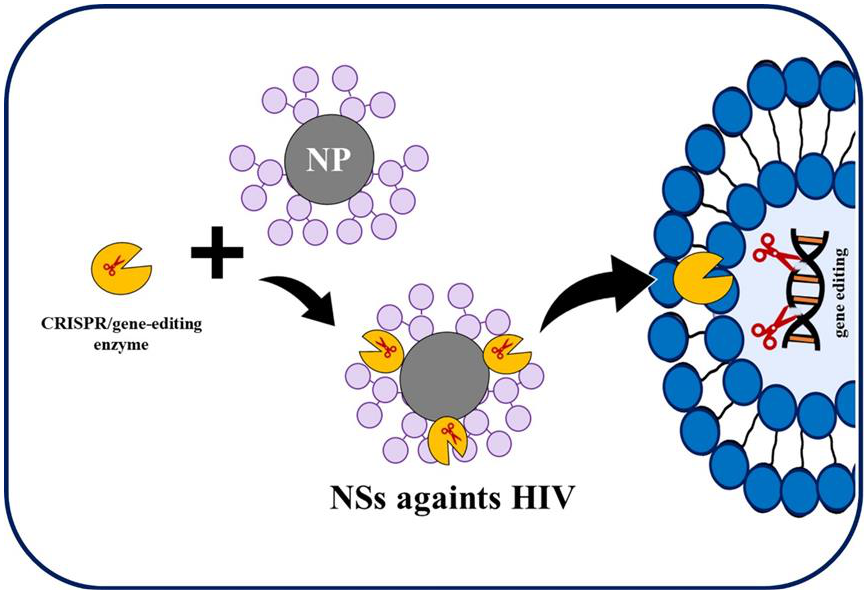
Figure 4. Indicative scheme of the gene editing approach.